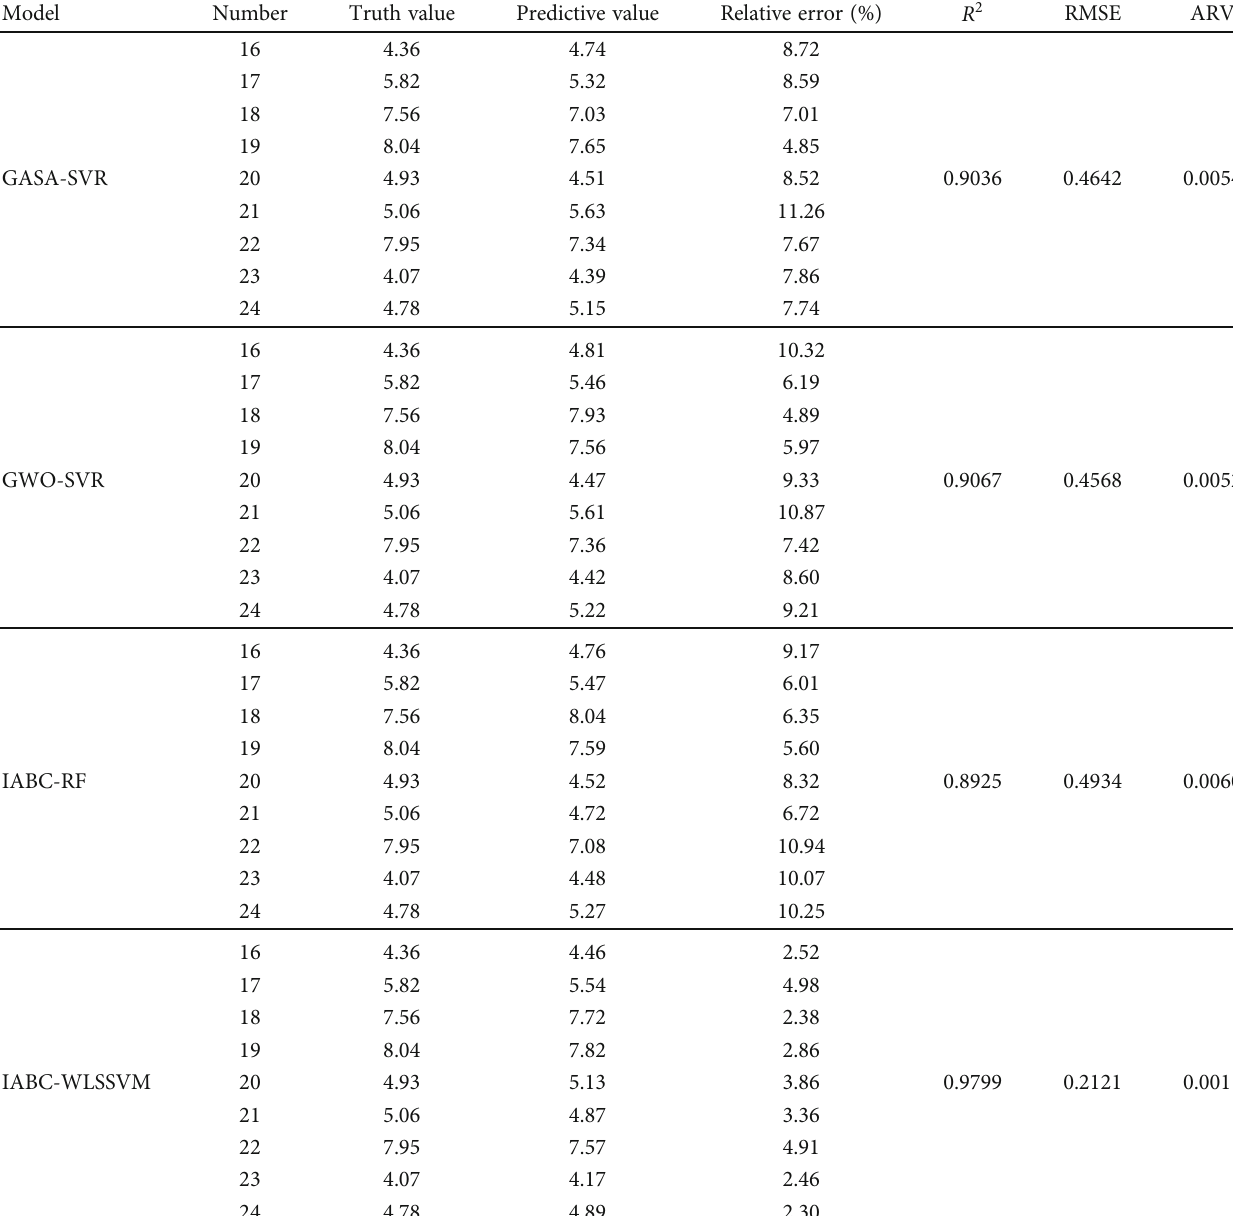
Table 7: Comparison of prediction performance of four